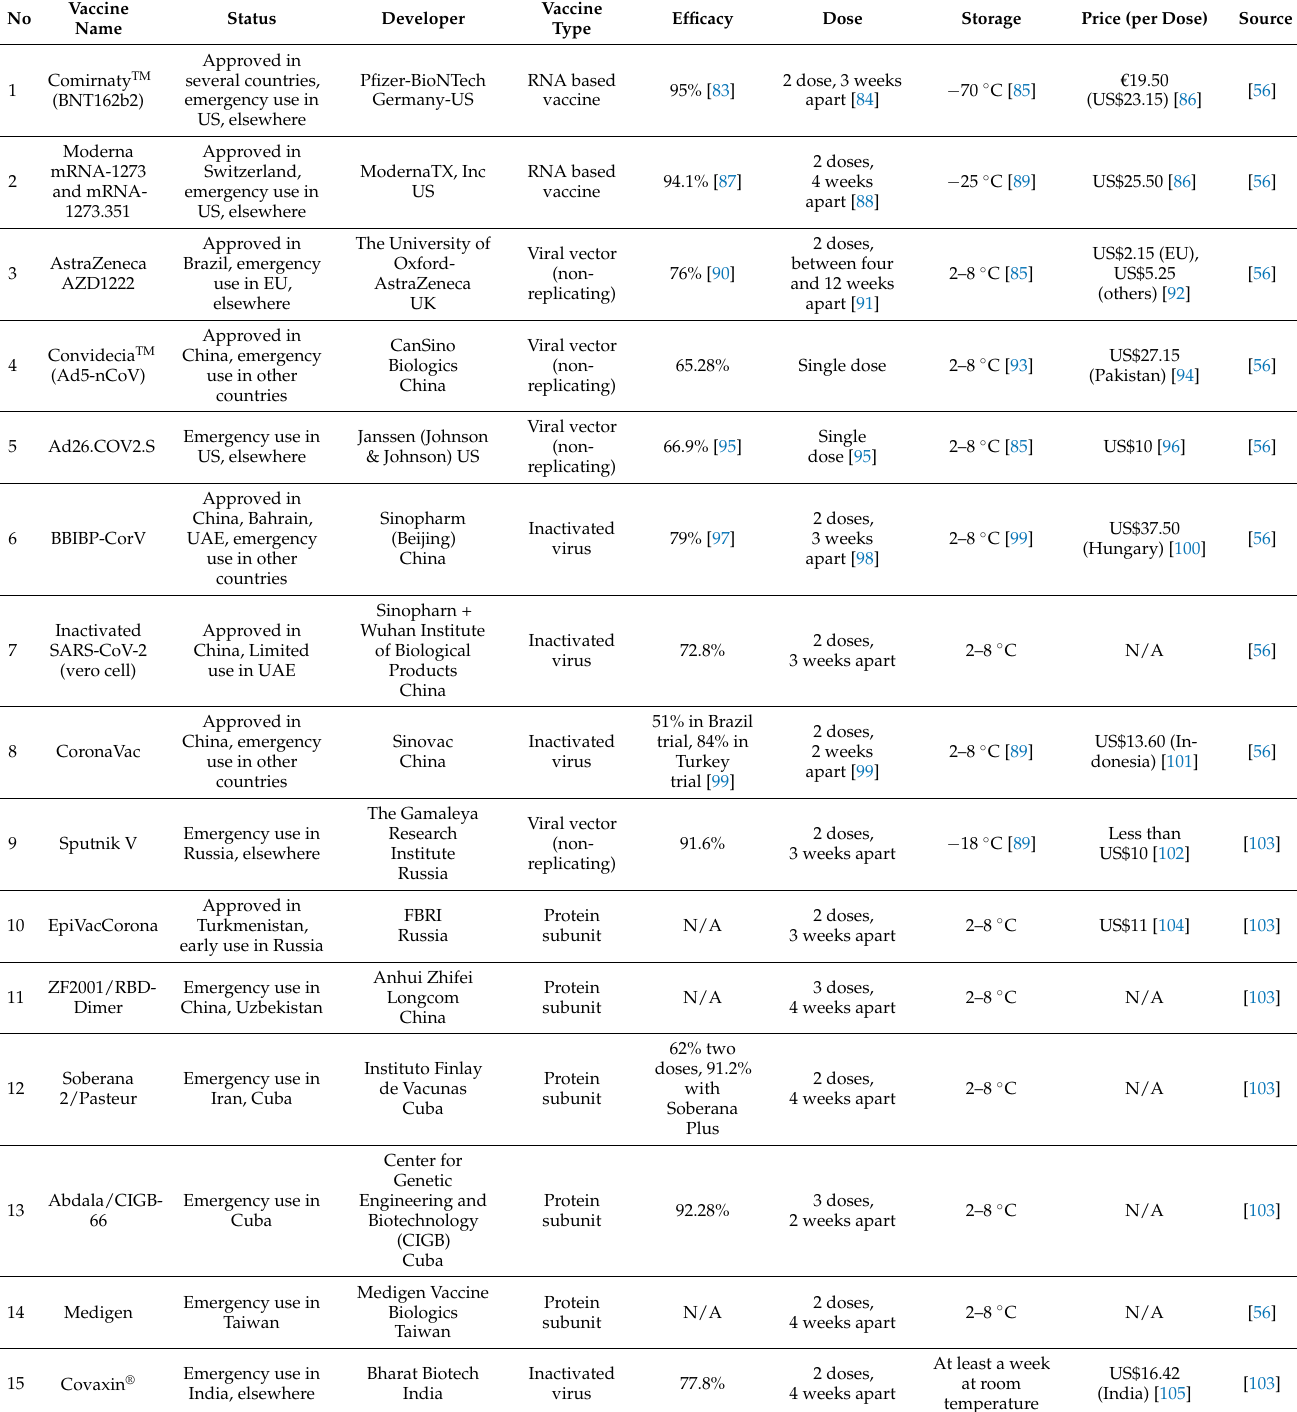
Table 2. Authorized/approved vaccines in at least one country as per 15 November